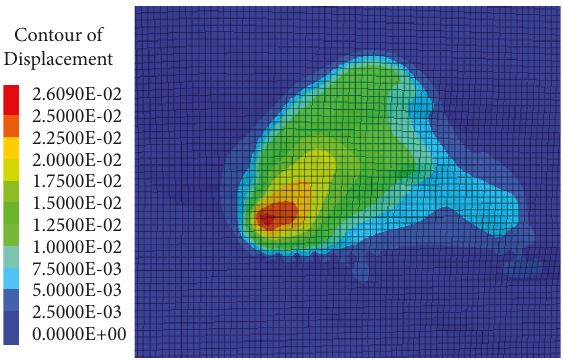
Figure 20: Displacement nephogram under polyline pile reinforcement.